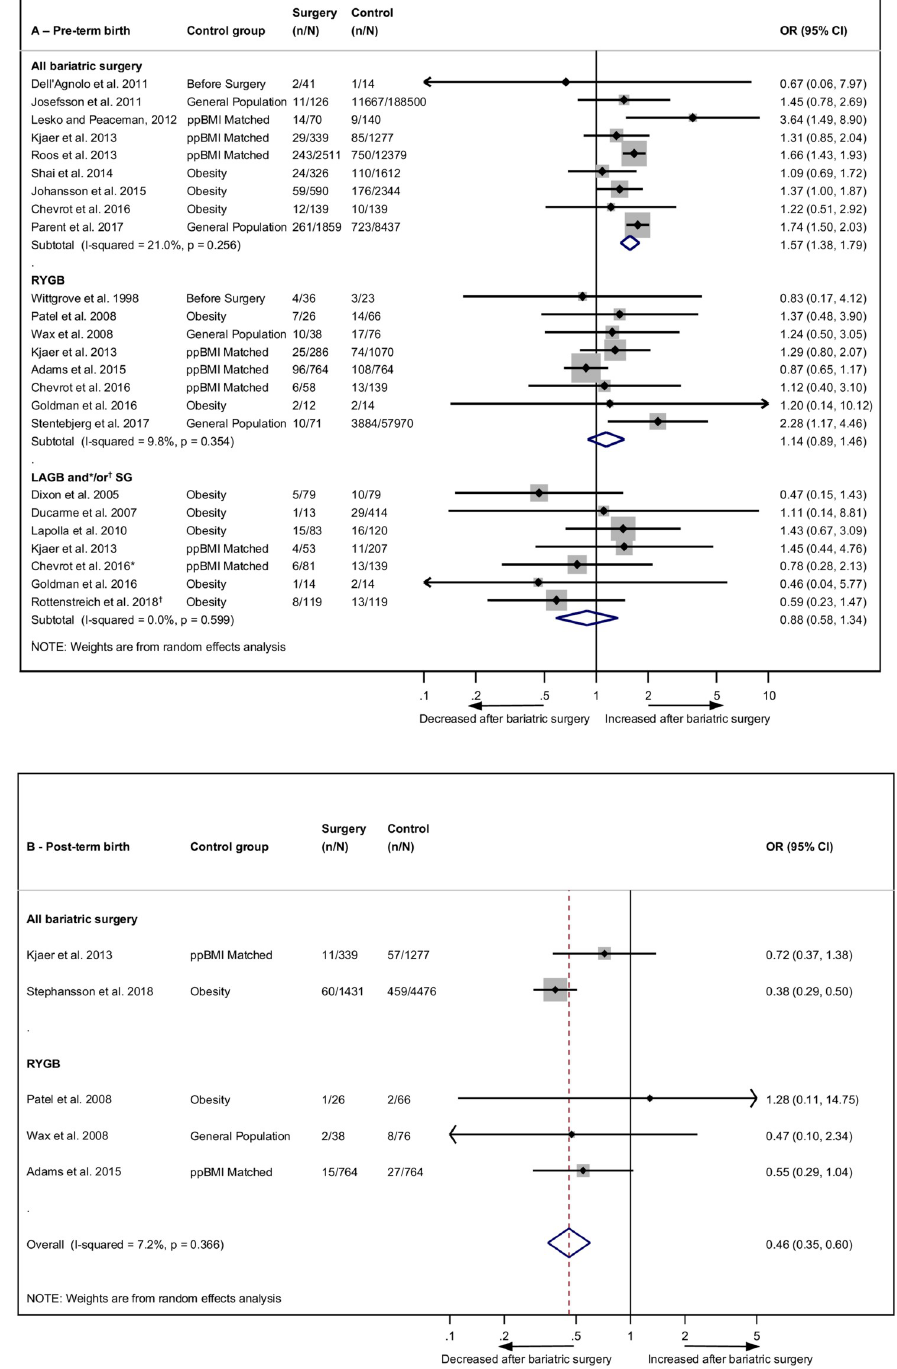
Fig 3. Preterm and postterm birth after bariatric surgery meta-analysis. Association between maternal bariatric surgery and (A) preterm birth ( < 37 weeks) and (B) postterm birth ( > 41 or > 42 weeks). Studies are presented as Author, year. The forest plots are stratified by type of surgery, with separate pooled OR (95% CI) when subgroup analysis was possible. n = cases of preterm or postterm birth. N = total group size. � LAGB and SG. † SG only. CI, confidence interval; LAGB, laparoscopic adjustable gastric banding; OR, odds ratio; ppBMI, prepregnancy body mass index matched; RYGB, Roux-en-Y gastric bypass; SG, sleeve gastrectomy.